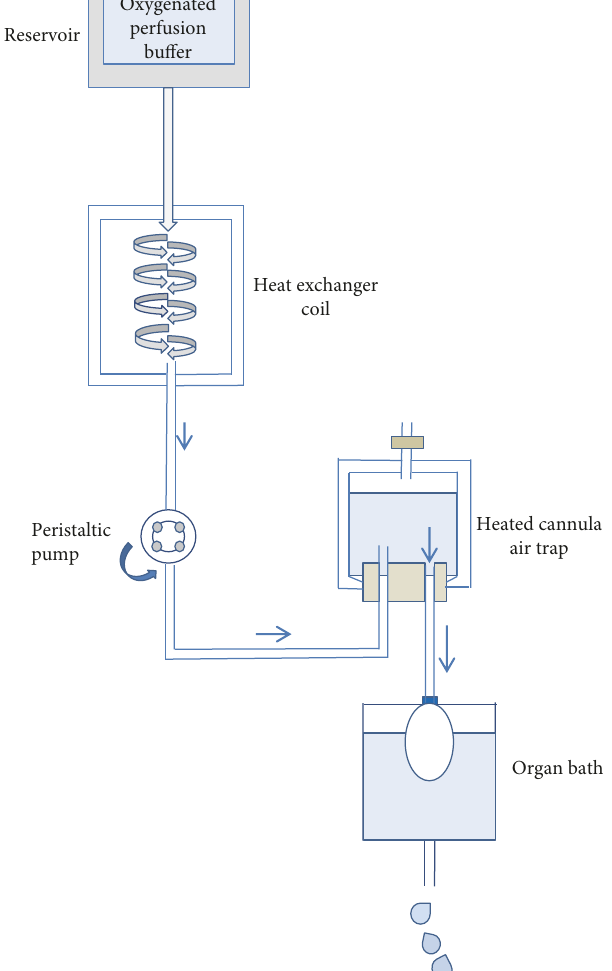
Figure 2: Schematic con fi guration of the Langendor ff apparatus system as applied